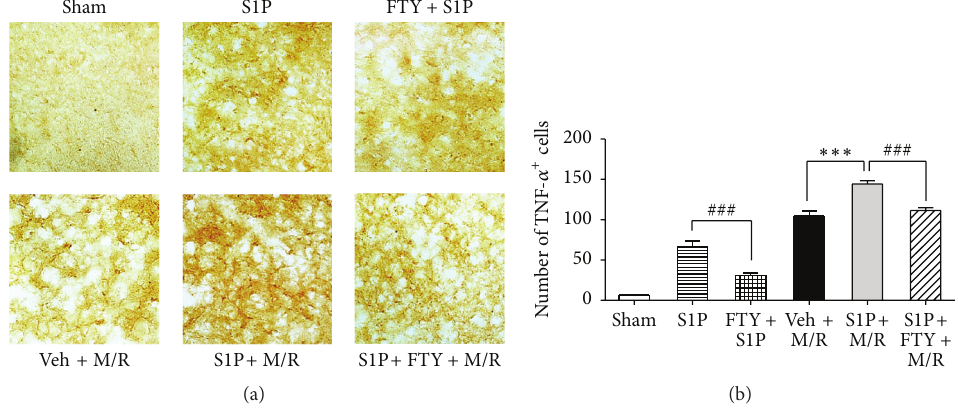
Figure 7: Activation of S1P signaling induces augmented TNF- 𝛼 expression following M/R injury. S1P or vehicle (veh) was injected into the corpus callosum 24h prior to M/R challenge (60min occlusion followed by 22 h reperfusion). FTY720 (FTY) was administered into mice 30 min prior to S1P microinjection (FTY + S1P) or 60 min occlusion (S1P + FTY + M/R). Cells expressing TNF- 𝛼 were assessed 1 day or 22 h after S1P microinjection or reperfusion. Representative microphotographs of brain sections immunolabeled against TNF- 𝛼 (a) and their quantitative analysis (b) in groups of sham, S1P, FTY + S1P, veh + M/R, S1P + M/R, and S1P + FTY + M/R. Significance was presented only for the main groups as indicated. ∗∗∗ 𝑃 < 0.001 , compared with M/R group (veh + M/R) (Newman-Keuls test). ### 𝑃 < 0.001 , compared with the S1P or S1P + M/R group (Newman-Keuls test). 𝑛 = 3 per group. Scale bar, 50 𝜇